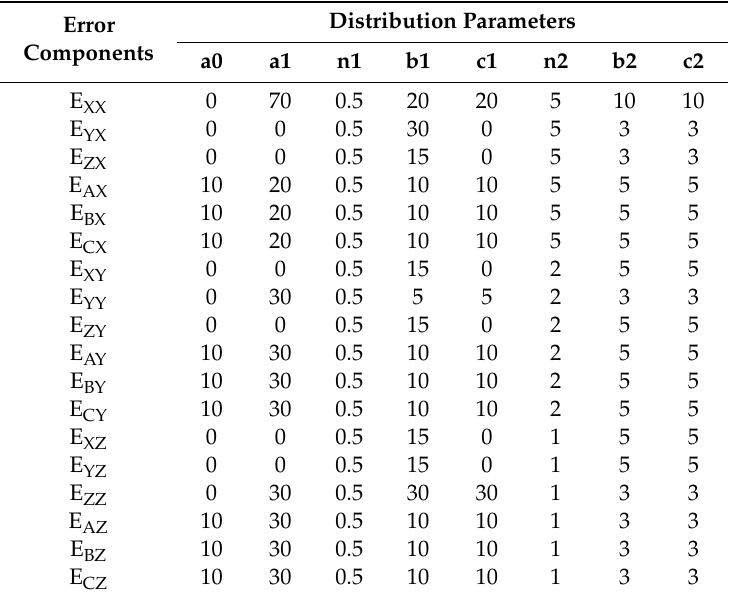
Table 1. Parameters used to generate the 18 geometric errors contained in a three-axis machine tool according to ISO